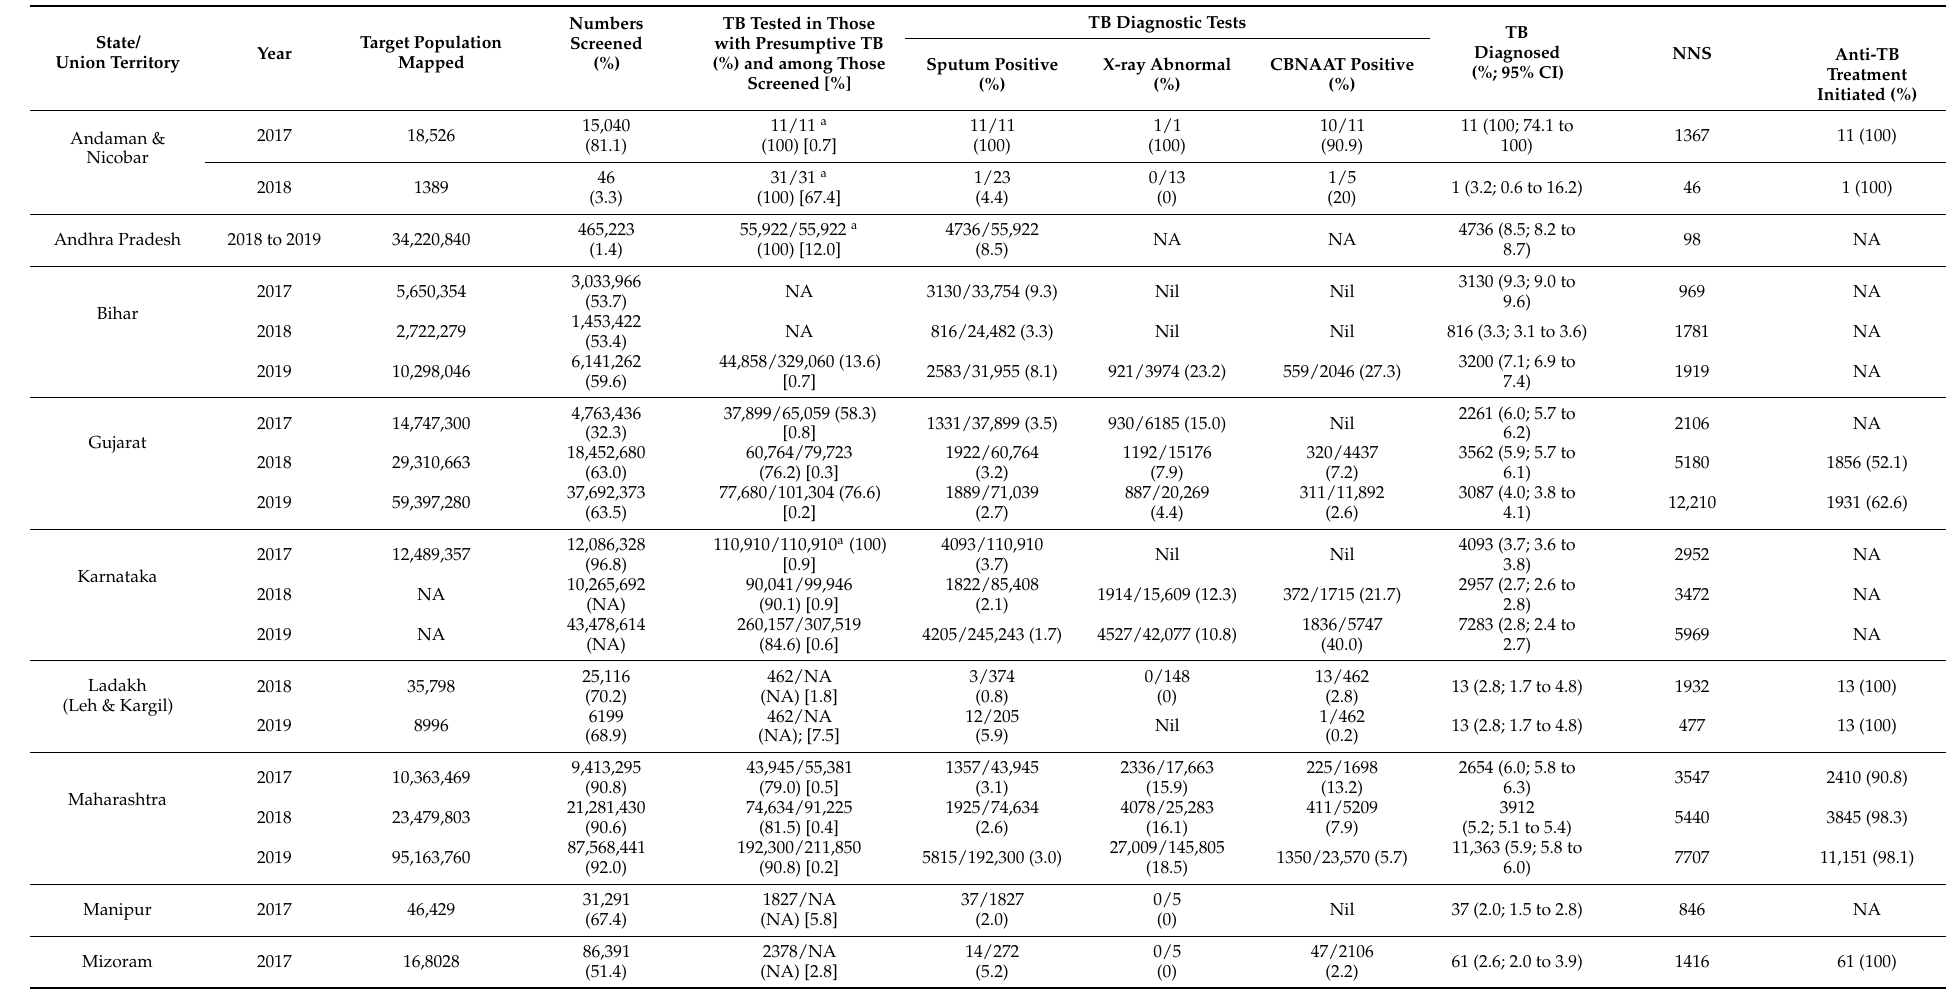
Table 2. Activities and outcomes of the active case finding (ACF) campaigns conducted in the states and union territories in India from the available data provided by the National TB Elimination Programme managers